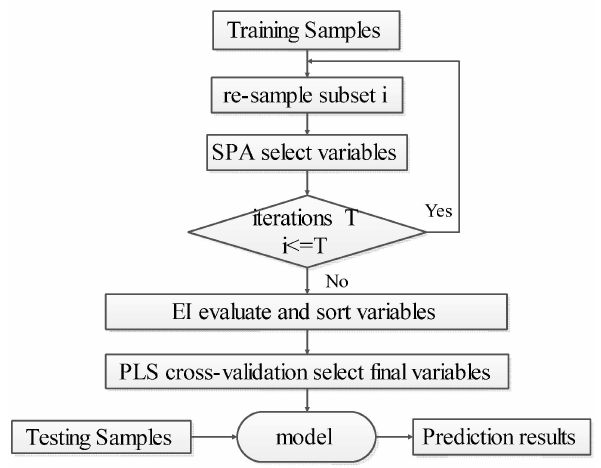
Figure 2. Flowchart of the proposed